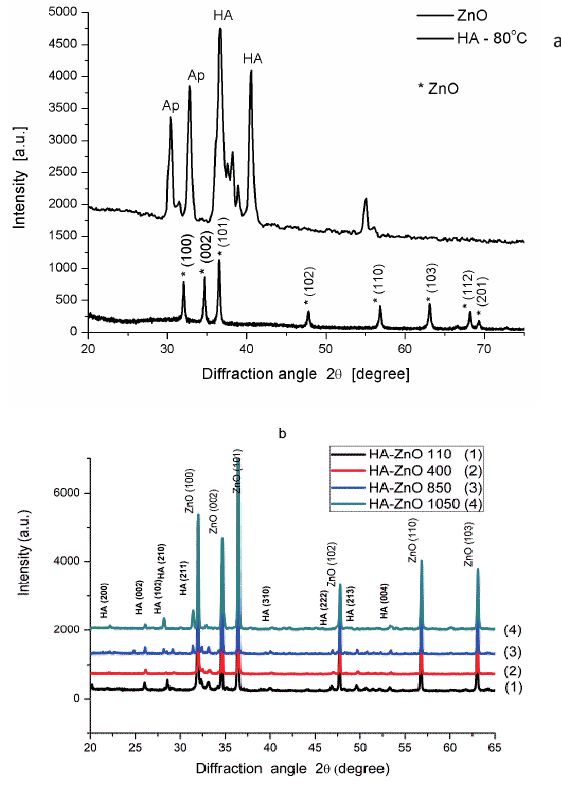
Figure 1: (a) X-ray diffraction pattern for ZnO powder and the analyzed samples with HA (80°C) -crystalline structure phase ( b) X-ray diffraction patterns for the analyzed samples with HA-ZnO -crystalline structure